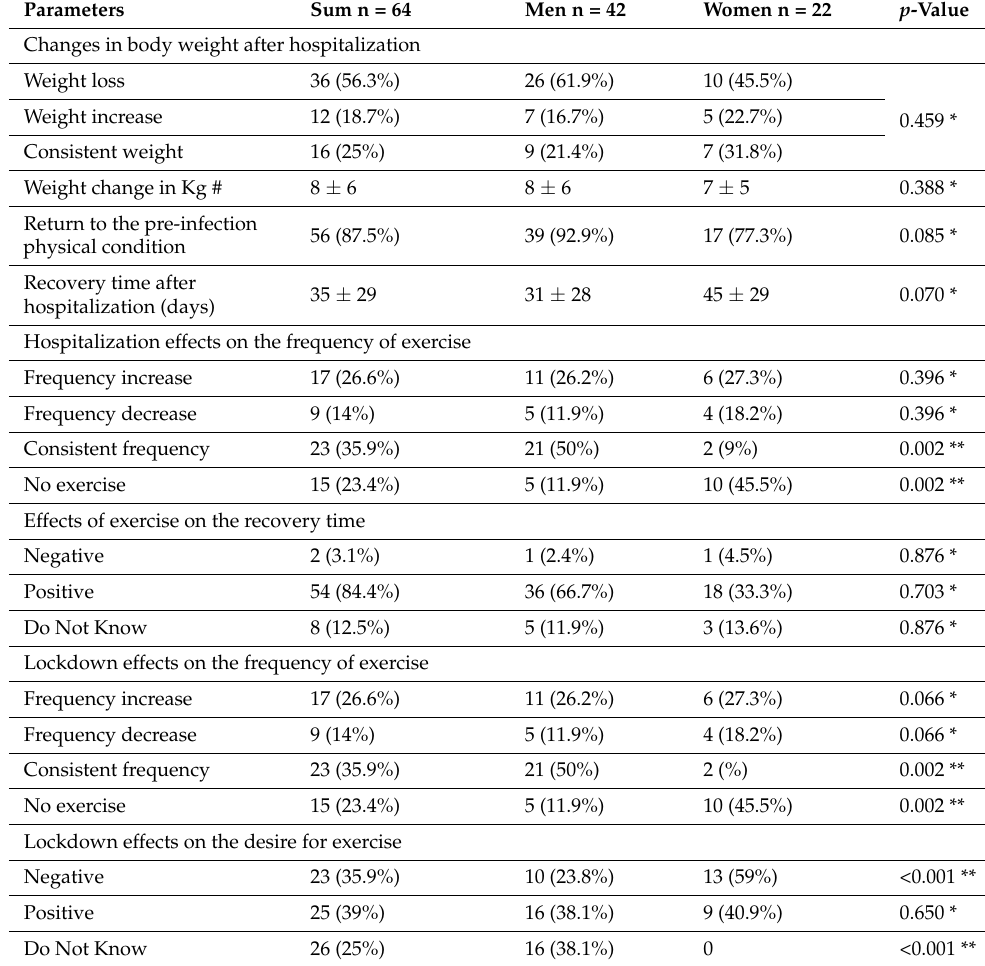
Table 6. Changes in body weight before and after hospitalization, views about the effects of hospital- ization on the frequency of exercise after discharge and during recovery, effects of the lockdown to the frequency and the desire of the study’s population to exercise and their comparison based on sex, n =